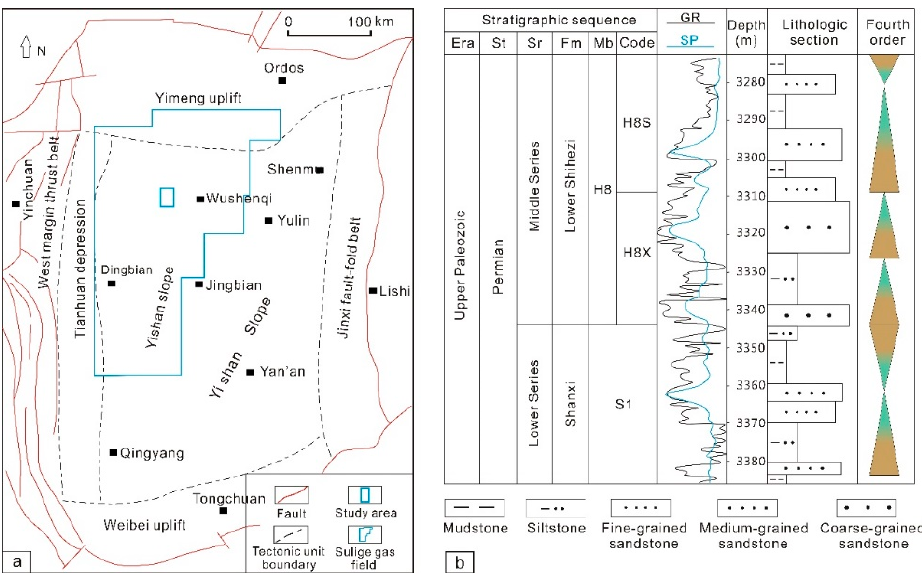
Figure 1. ( a ) Location map of S6 area in Sulige gas field; ( b ) Stratigraphy of upper Paleozoic; only the H8 and S1 layers are shown.